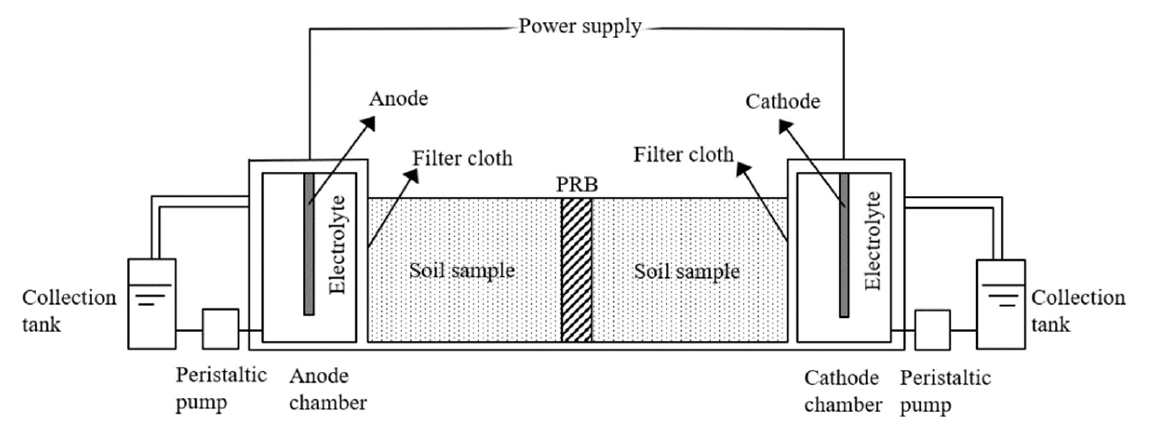
Figure 1. Schematic diagram of EK-PRB reaction device.